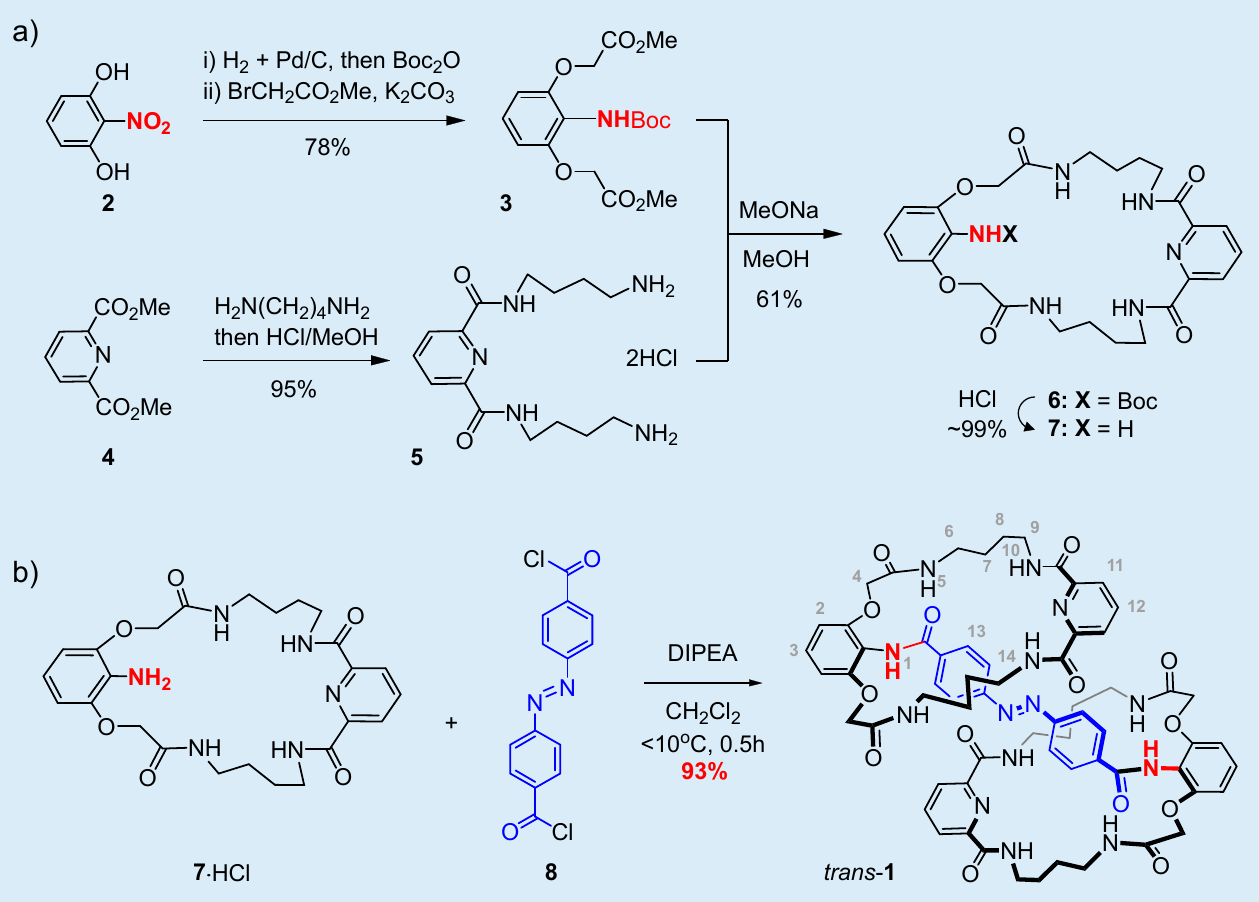
Scheme 1. Synthesis of macrocyclic amine 4 ( a ) and sterically C 2 -symmetrical crowded